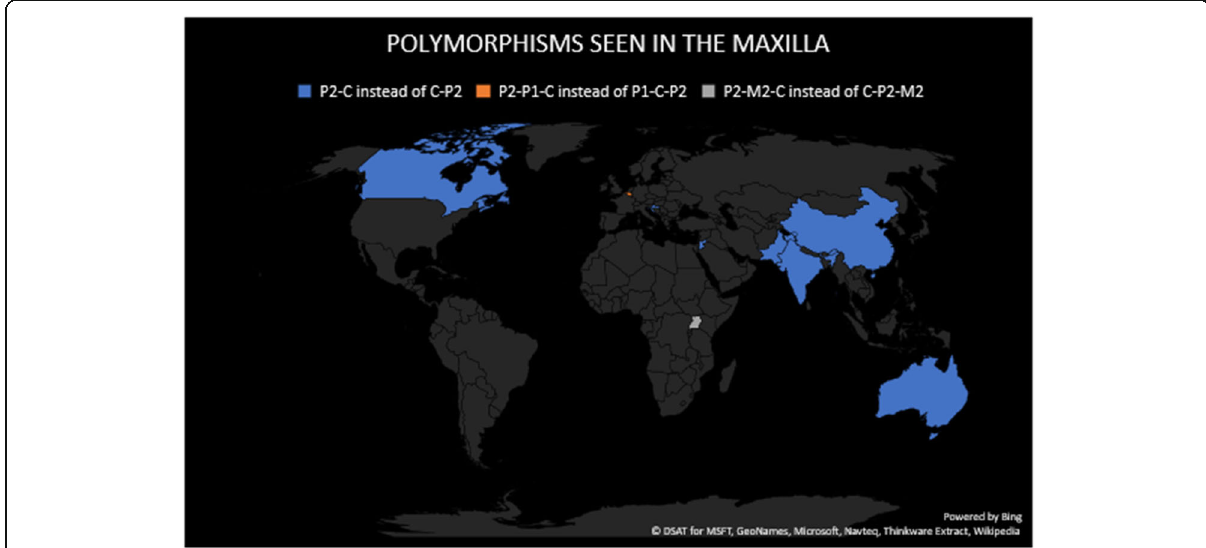
Fig. 2 Polymorphisms seen in the sequence of emergence of maxillary